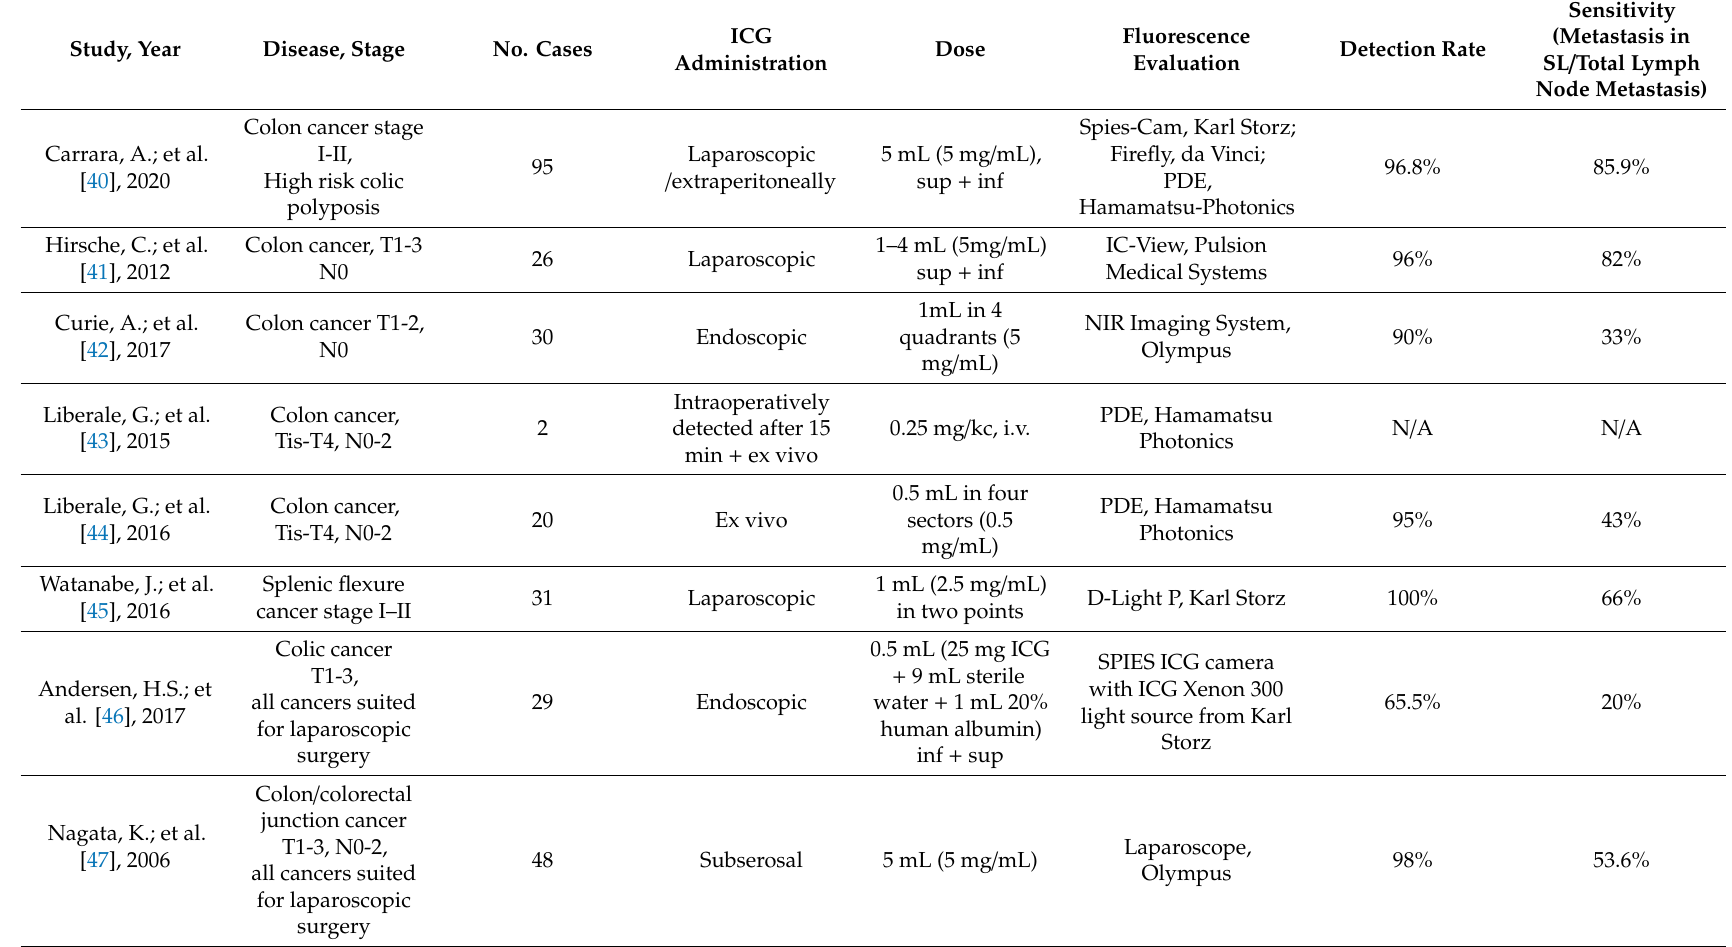
Table 2. Studies regarding NIR ICG detection of sentinel lymph node (SLN) in colorectal